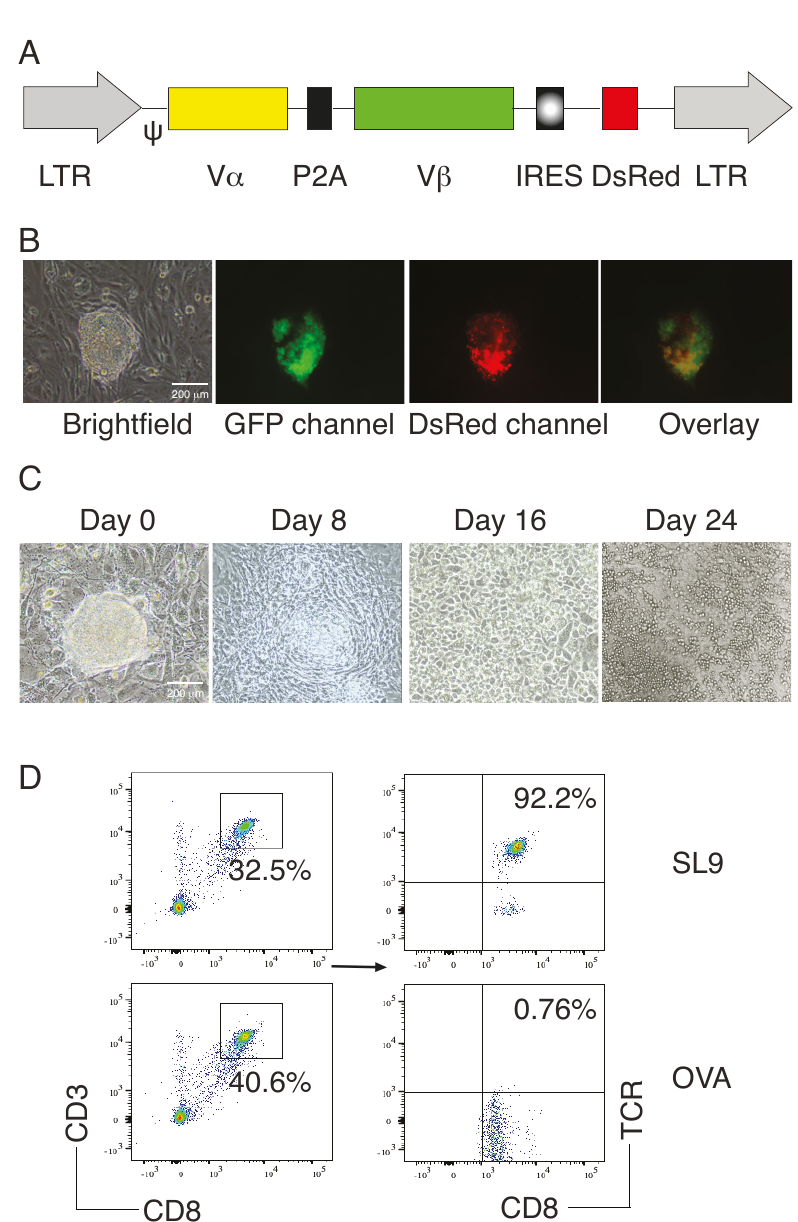
Figure 1. Generation of SL9-specific iPSC-CTLs. Mouse iPSCs were transduced with the following retroviral constructs: SL9 TCR (MiDR-SL9 TCR) or OVA 257–264 TCR (MiDR-OVA TCR), and the transduced iPSCs were co-cultured with OP9-DL1/DL4 stromal cells for T lineage differentiation. ( A ) Schematic representation of the retrovirus constructs expressing HIV SL9 TCR. Ψ , packaging signal; 2A, picornavirus self-cleaving 2A sequence; LTR, Long terminal repeats. ( B ) The SL9 TCR-transduced iPSCs were visualized by a fluorescence microscope. ( C ) Morphology of T cell differentiation on various days. ( D) Flow cytometric analysis of the iPSC-derived cells on day 28. CD3 + CD8 + cells were gated as indicated and analyzed for the expression of CD8 and SL9 TCR. Data shown are representative of three identical